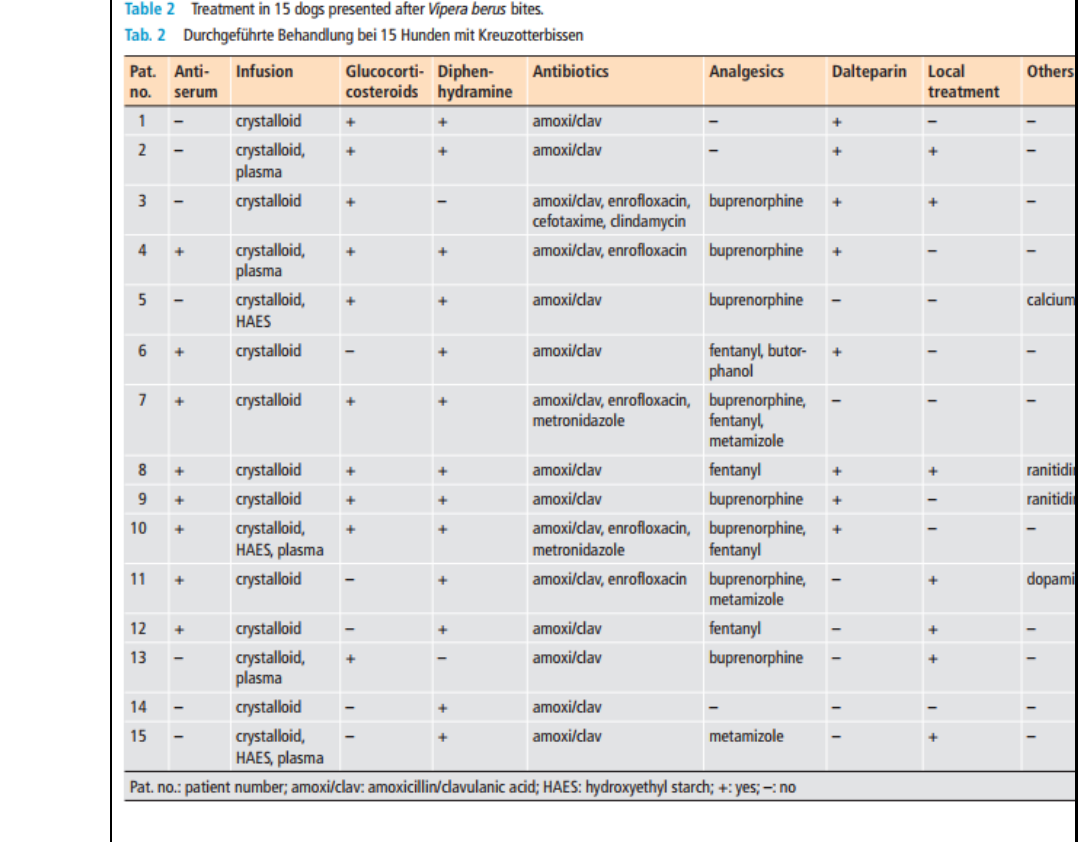
Figure1: Breakdown of treatment combinations given to dogs in the study by Turkovic et al,